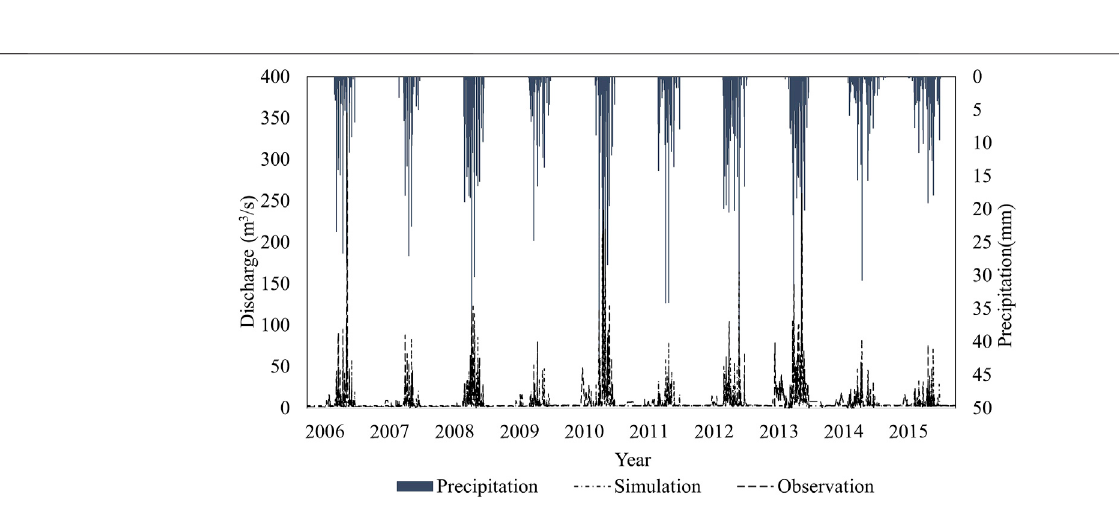
FIGURE 5 | The distribution and conversion of land use in 2006, 2008, 2012, and 2015.